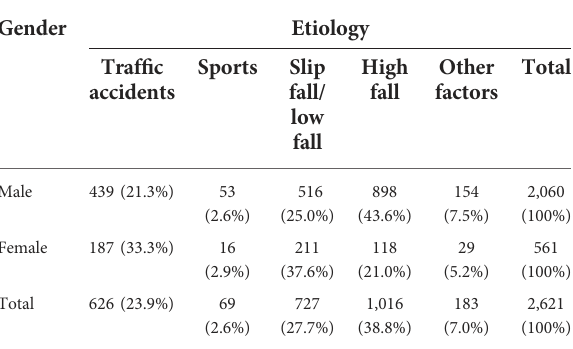
TABLE 3 Etiological composition ratio of TSCI in males and